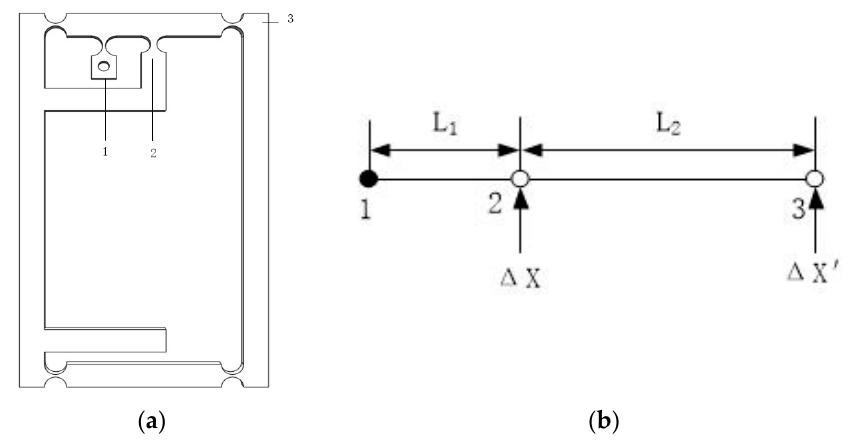
Figure 5. ( a ) Structure diagram of Amplification mechanism. ( b ) Schematic diagram of the lever amplification mechanism.